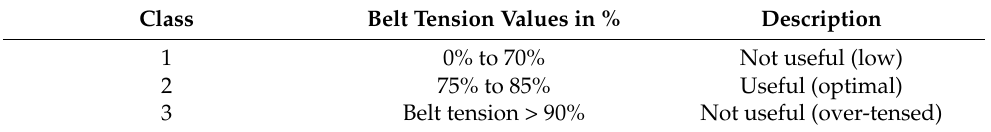
Table 9. Belt tension classes correlating to % belt tension